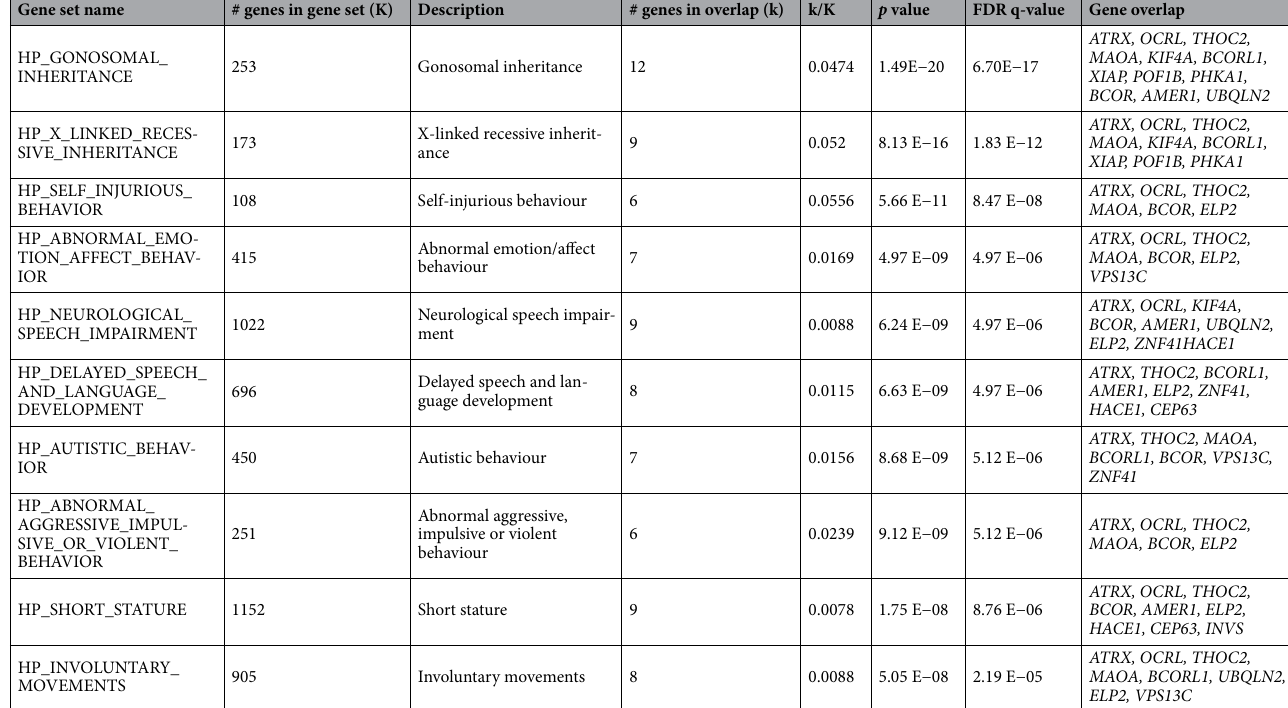
Table 4. Analysis of human phenotype